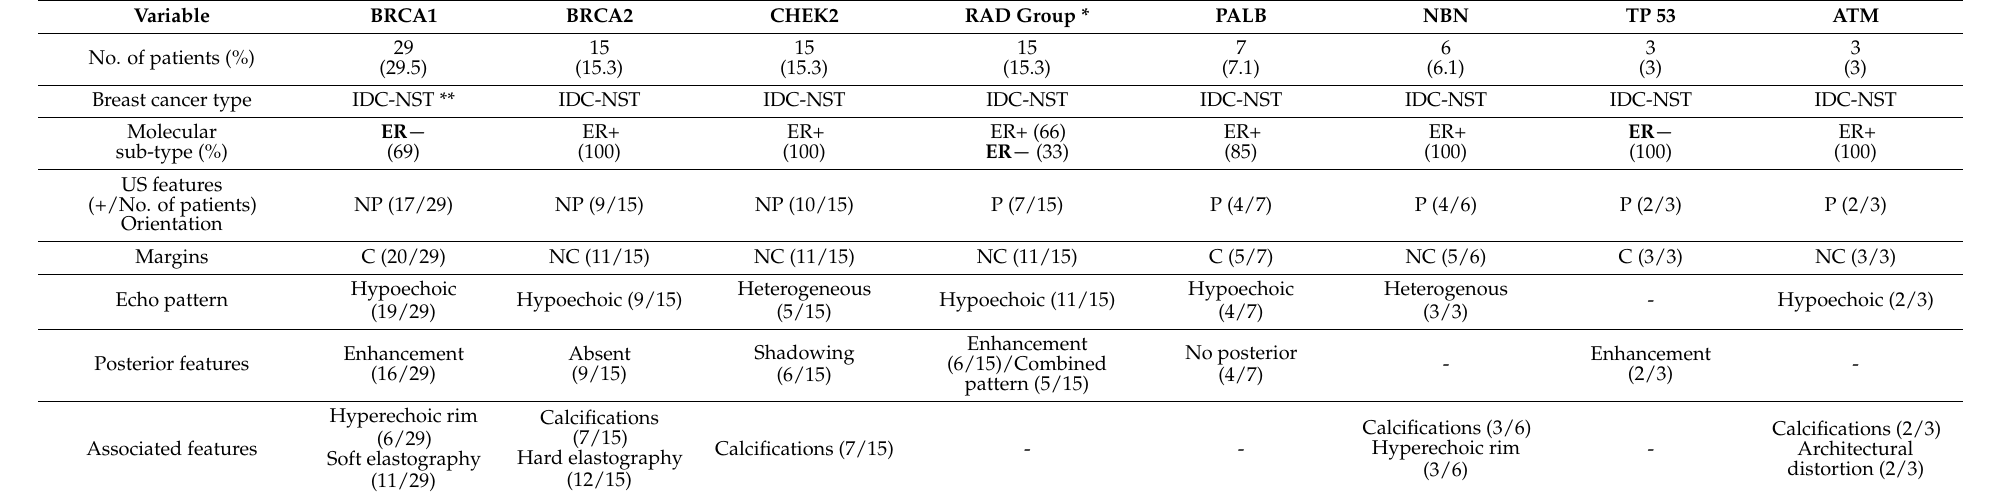
Table 3. Pathologic characteristics and US features of breast cancer patients associated with pathogenic